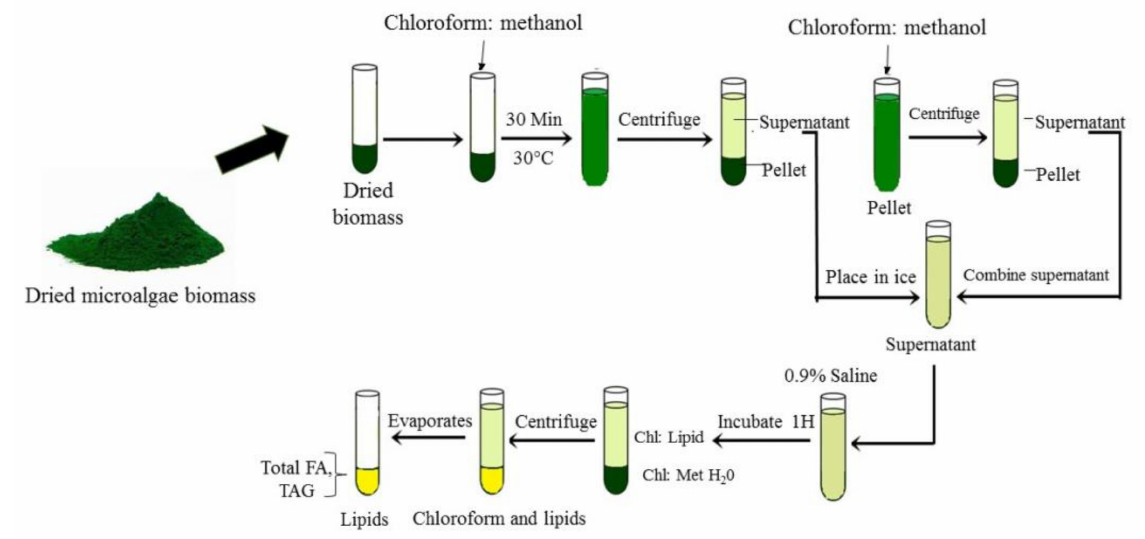
Figure 5. Microalgae lipid extraction by Bligh and Dyer and Folch